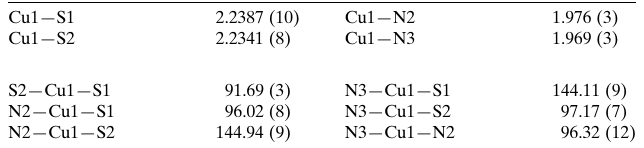
Selected geometric parameters (A˚ , (cid:3) ).